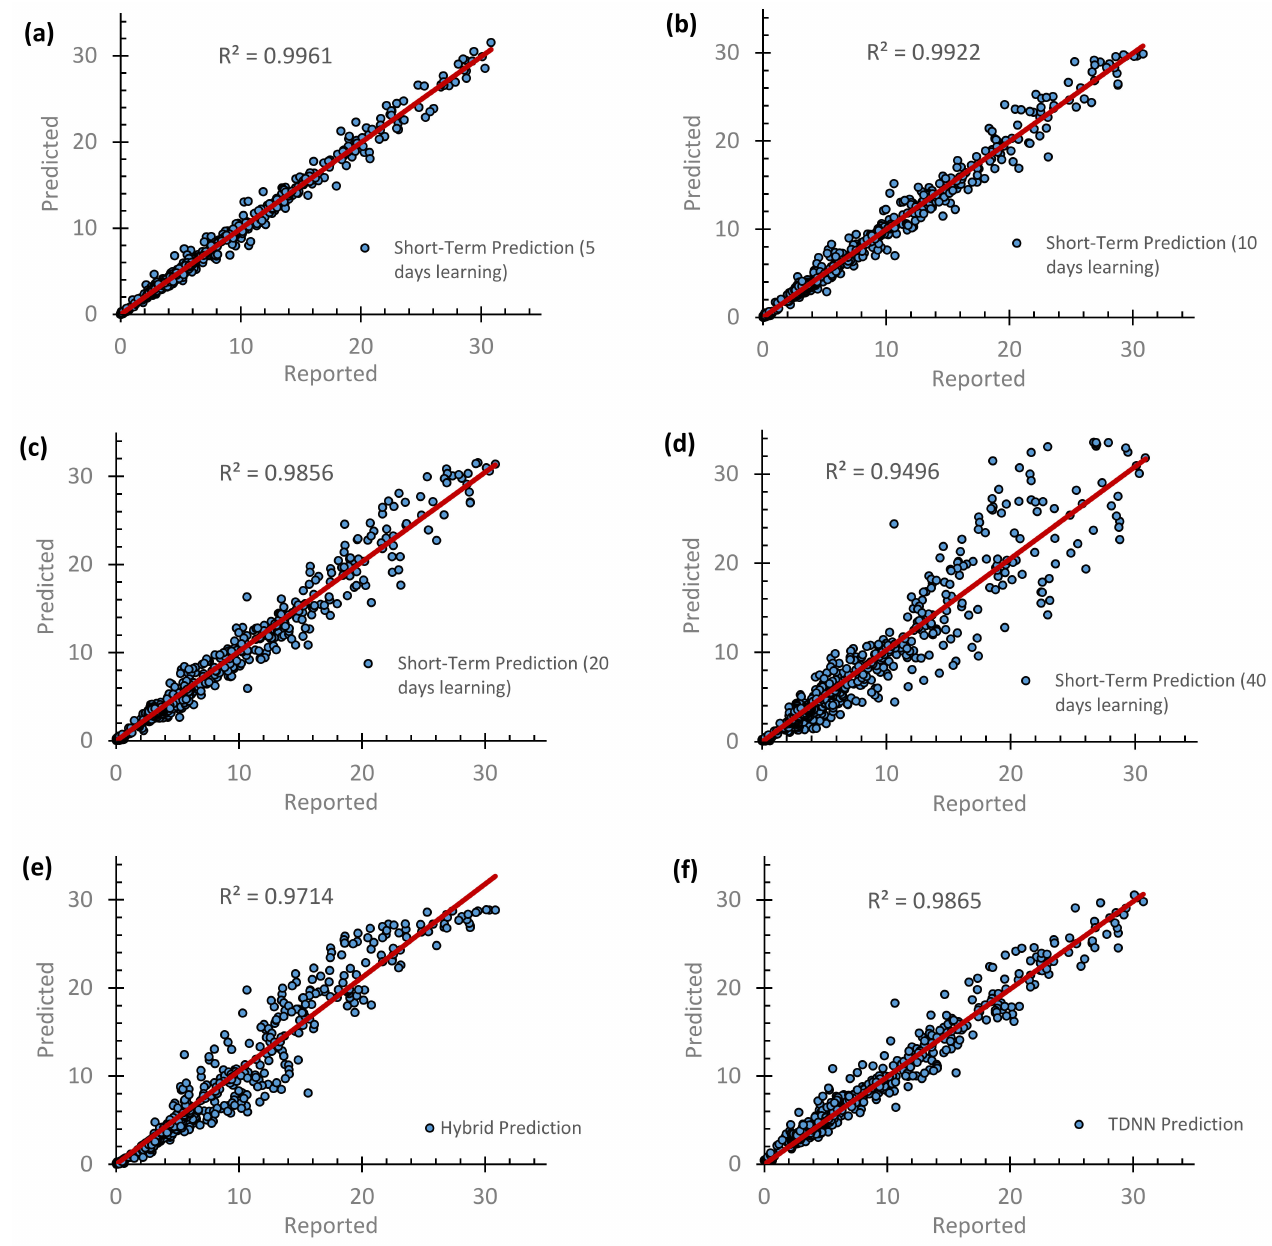
Figure 6. Comparisons of the forecasted versus the reported +qPCR daily cases, including the periods before and after the emergence of the OMICRON variant, using ( a – d ) STF model prediction that takes 5, 10, 20 and 40 days of learning, ( e ) HF model prediction and ( f ) TDNN